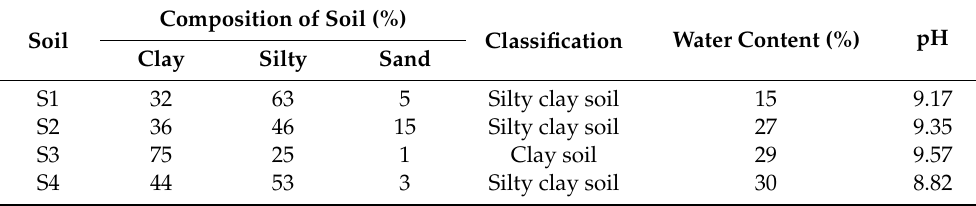
Table 1. Soil texture, classification (USDA), water content and pH of the four soils (S1, S2, S3, S4). Composition of Soil (%) Soil Classification Water Content (%) pH Clay Silty